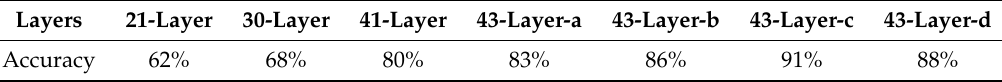
Table 4. The result of the experiment of the convolution